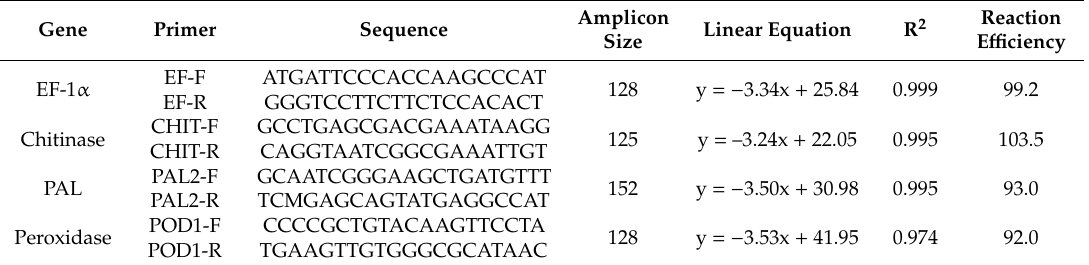
Reaction E ffi ciency